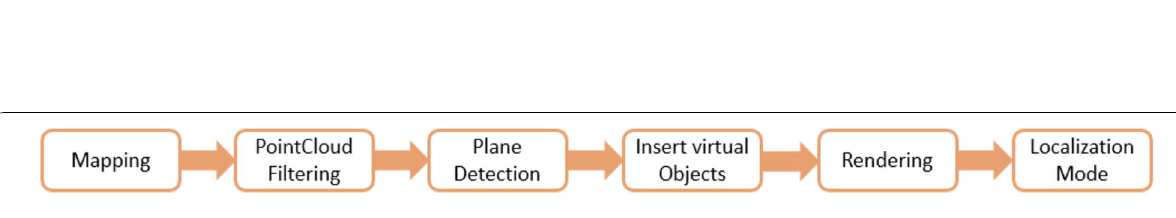
Figure 4 Steps for our Augmented-Reality-Advanced-Driver-Assistance-Systems-Approach